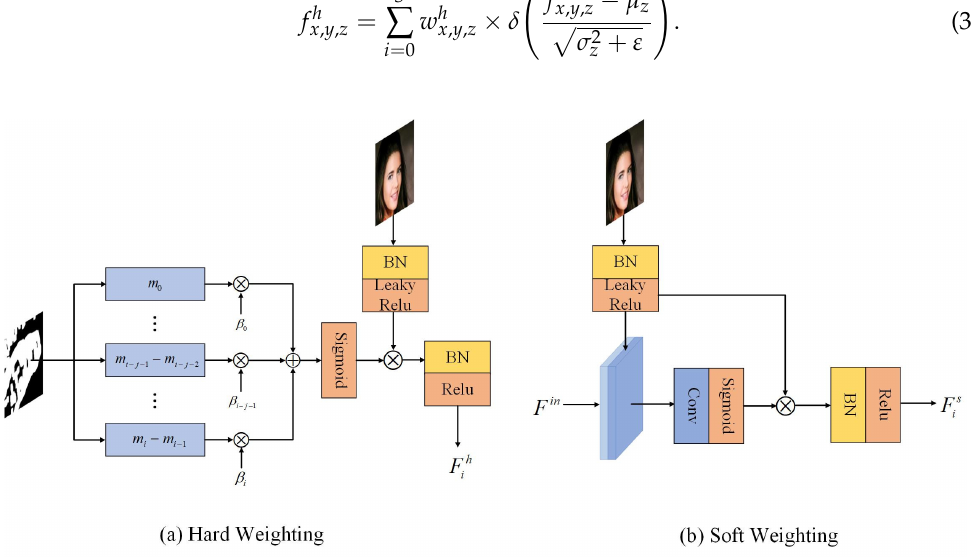
Figure 3. The details of the hybrid weighted merging